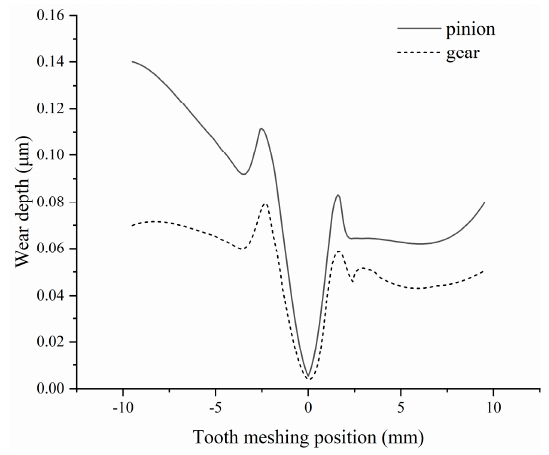
Figure 6. Wear depth of the pinion and gear.